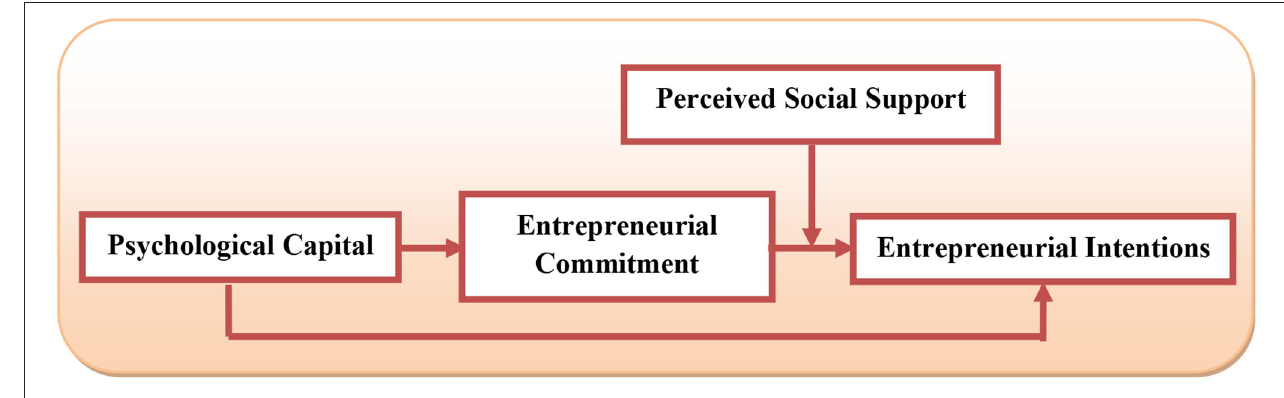
FIGURE 1 | Research